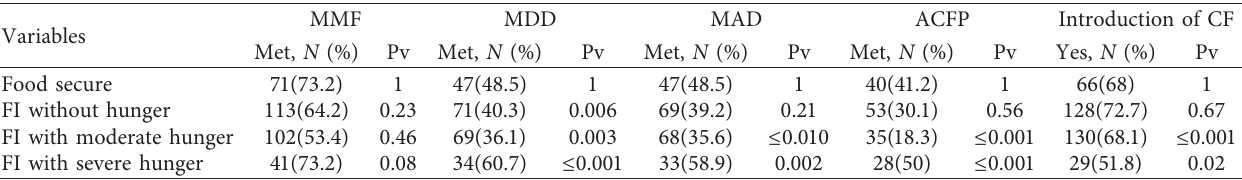
Table 4: Chi-square association of CF indicators with food security status among mothers of 6–23-month children in Shashemene city, Oromia, Ethiopia, 2020 ( N � 520).